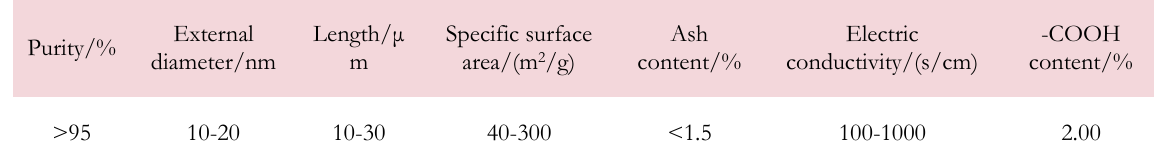
Table 1: The basic physical parameters of carbon nano-tubes.